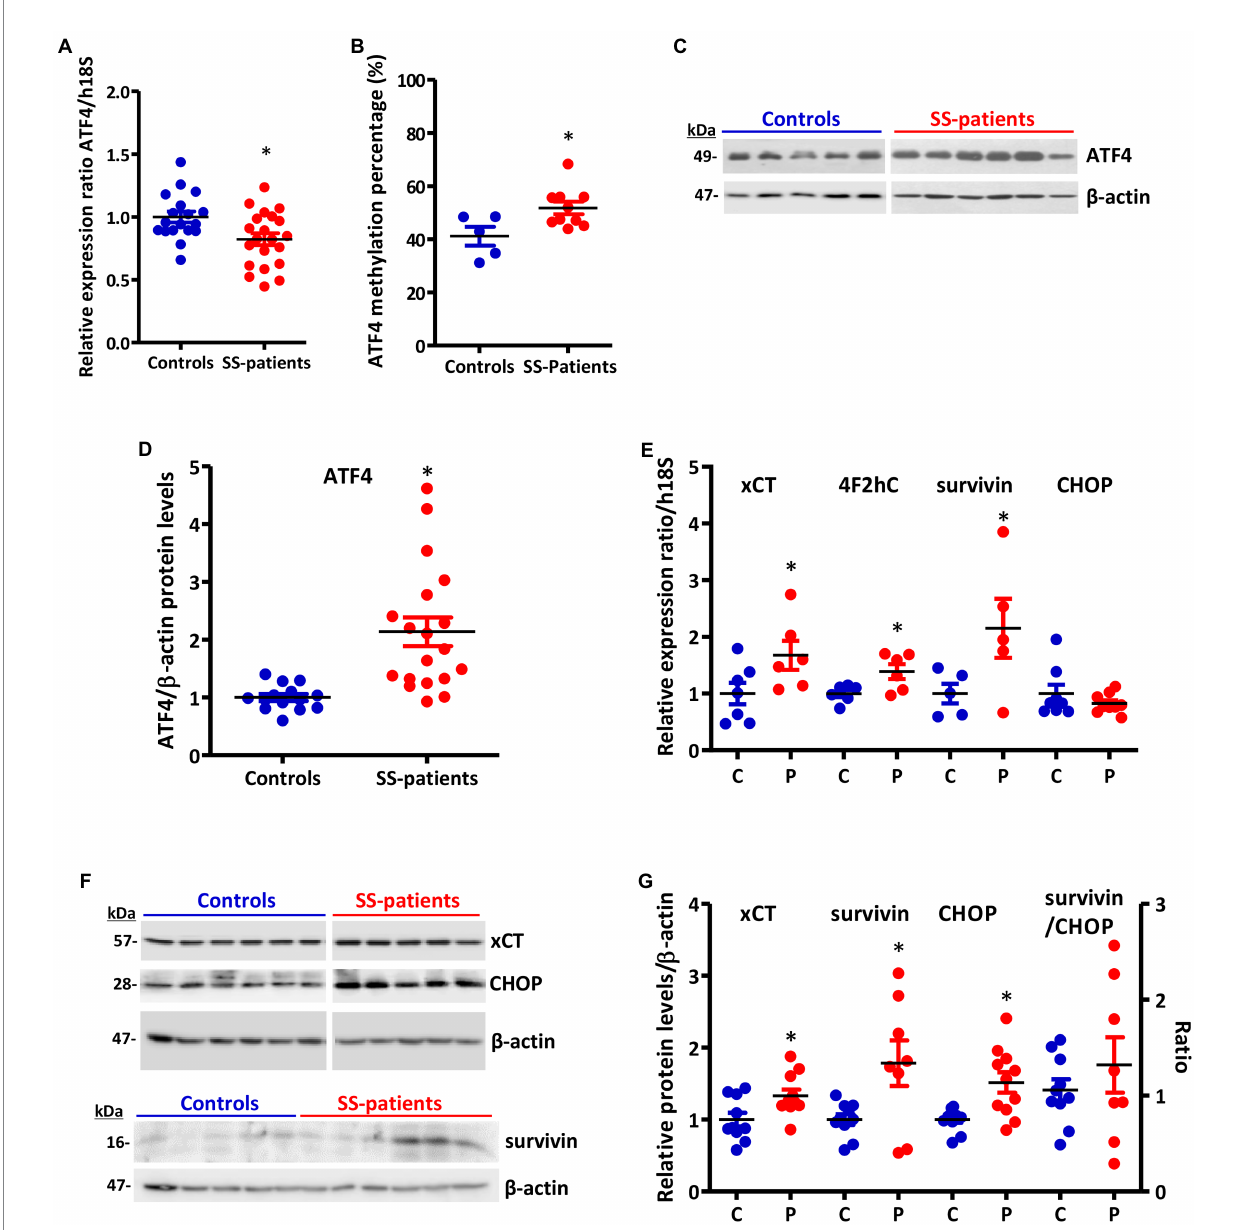
FIGURE 12 Expression of ATF4 and ATF4-target genes in LSGs of control and SS-patients. (A) Dot plot showing ATF4 transcript levels relative to h18S from control (C) and SS-patients (P) ( n = 18C, 21P). (B) Dot plot showing ATF4 promoter-specific DNA methylation ( n = 5C, 10P). (C) representative images of ATF4 immunoblot from control and SS-patients using β -actin as a loading control. (D) Dot plot showing densitometric analysis of ATF4 ( n = 11C, 19P). (E) Dot plot showing xCT ( n = 7C, 6P), 4F2hc ( n = 6C, 6P), survivin ( n = 5C, 5P) and CHOP ( n = 8C, 9P) transcript levels relative to h18S. (F) Representative images of xCT, survivin, and CHOP immunoblot from control and SS-patients using β -actin as a loading control. (G) Dot plot showing densitometric analysis of xCT ( n = 10C, 11P), survivin ( n = 10C, 8P), CHOP ( n = 11C, 11P) and survivin/CHOP ratio ( n = 10C, 8P). These experiments were repeated at least three times (*). p values lower than 0.05 were considered